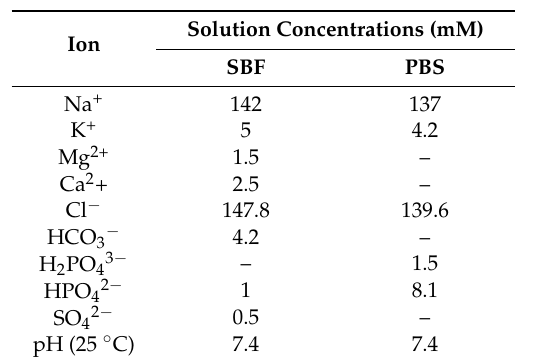
Table A2. Nominal ion concentrations of simulated body fluid (SBF) [39] and phosphate buffered saline (PBS) used in corrosion studies.